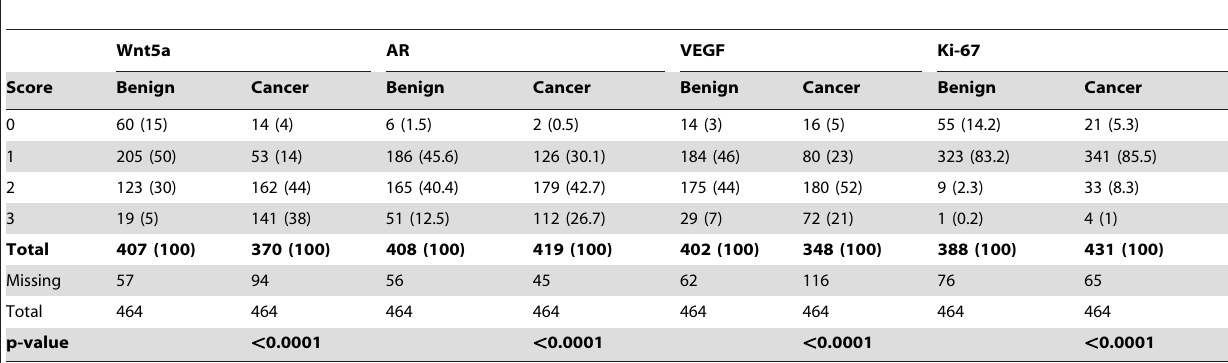
Table 2. Scoring data from Wnt5a, AR, VEGF and Ki-67 immunostained cores from benign and cancer tissues in duplicates mounted in a TMA.